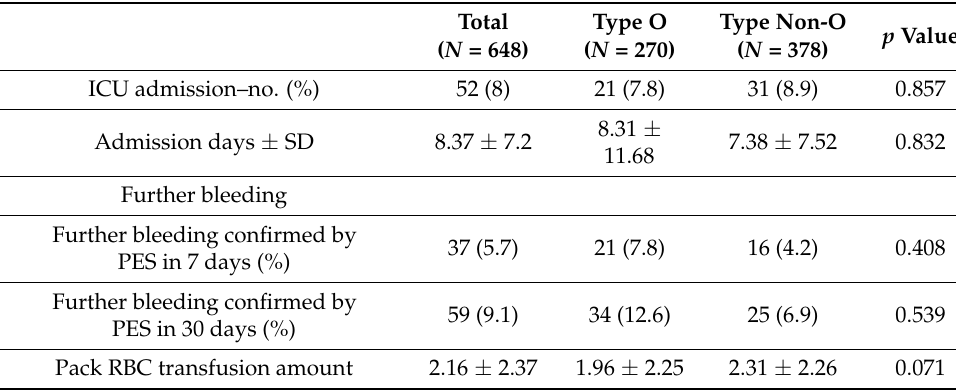
Table 5. Secondary